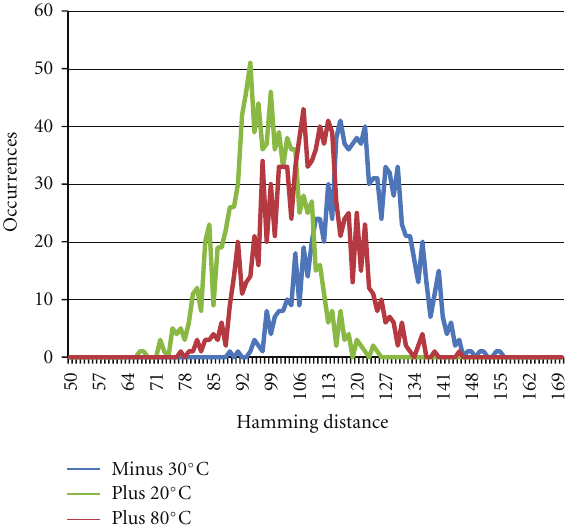
Figure 12: Hamming distance of single readback and masterbit- stream of board D at di ff erent temperatures.